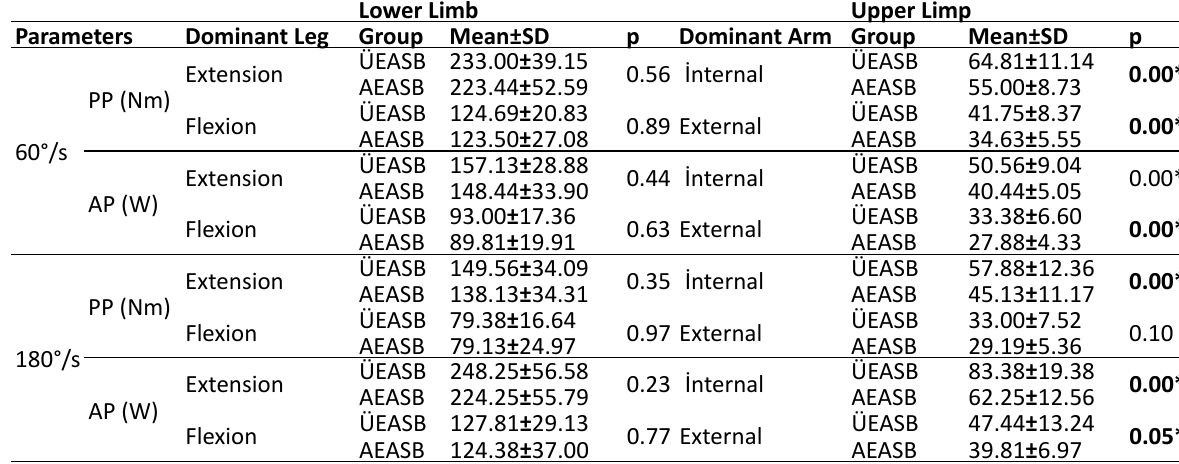
Table 6. Dominant arm and leg isokinetic force results of the participants at 60°/s and 180°/s rotation in terms of extremity dominancy.